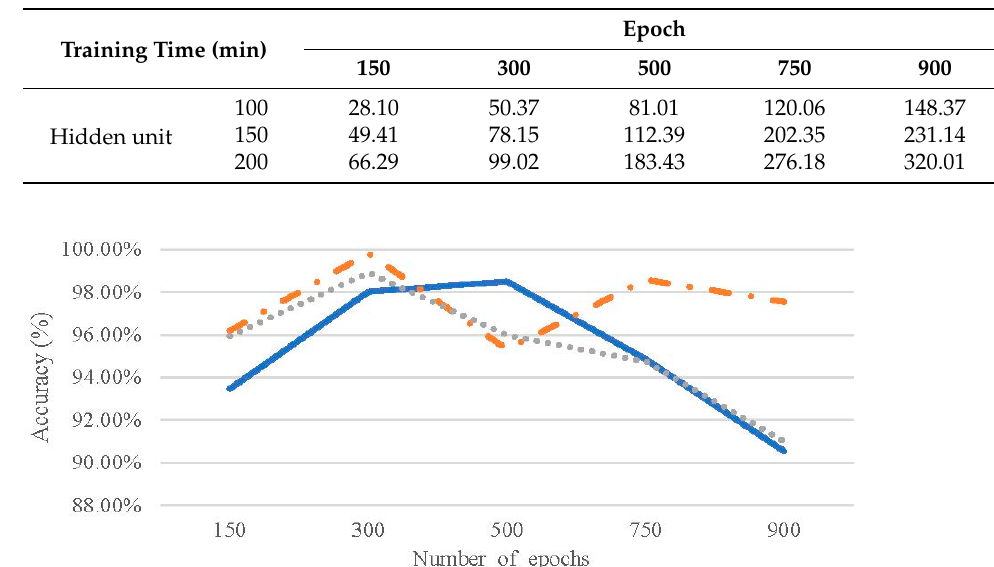
Table 2. Training accuracy according to numbers of epochs and hidden units.